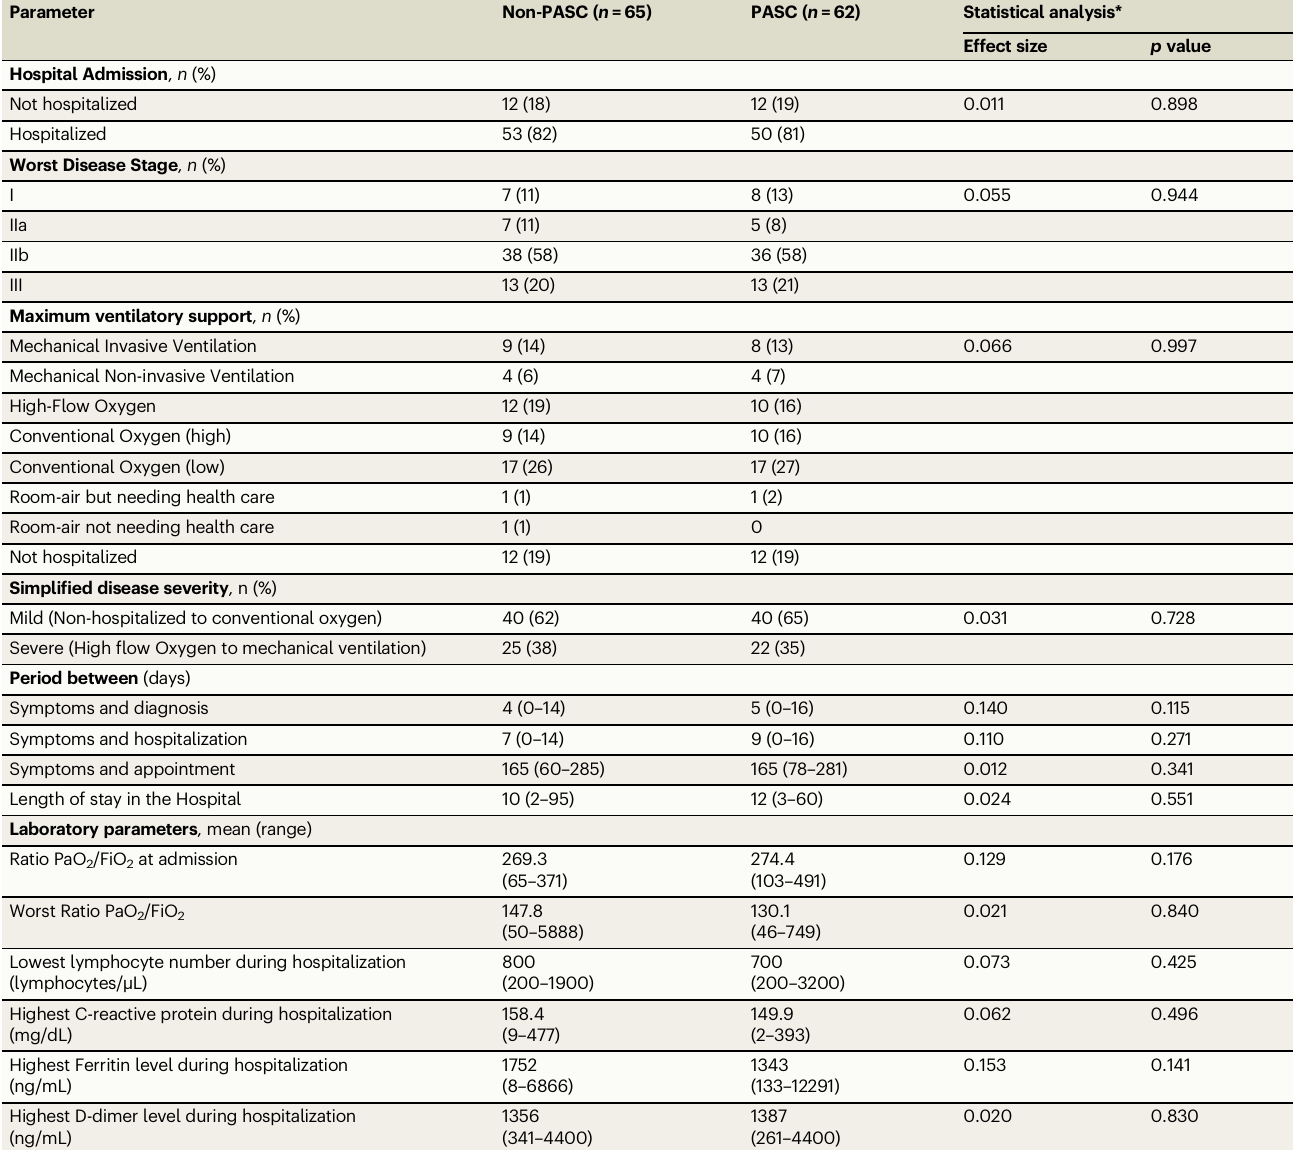
Table 2 | Clinical observations during hospitalization of non-PASC and PASC patients Parameter Non-PASC ( n =65)